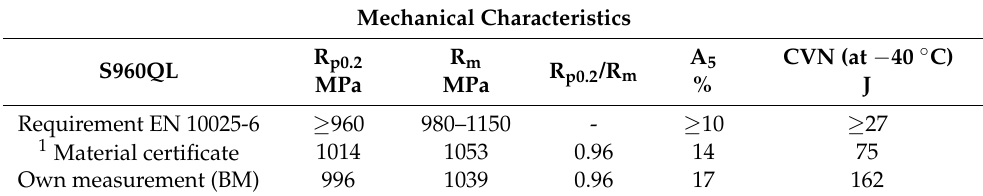
Table 2. Mechanical properties of the investigated S960QL